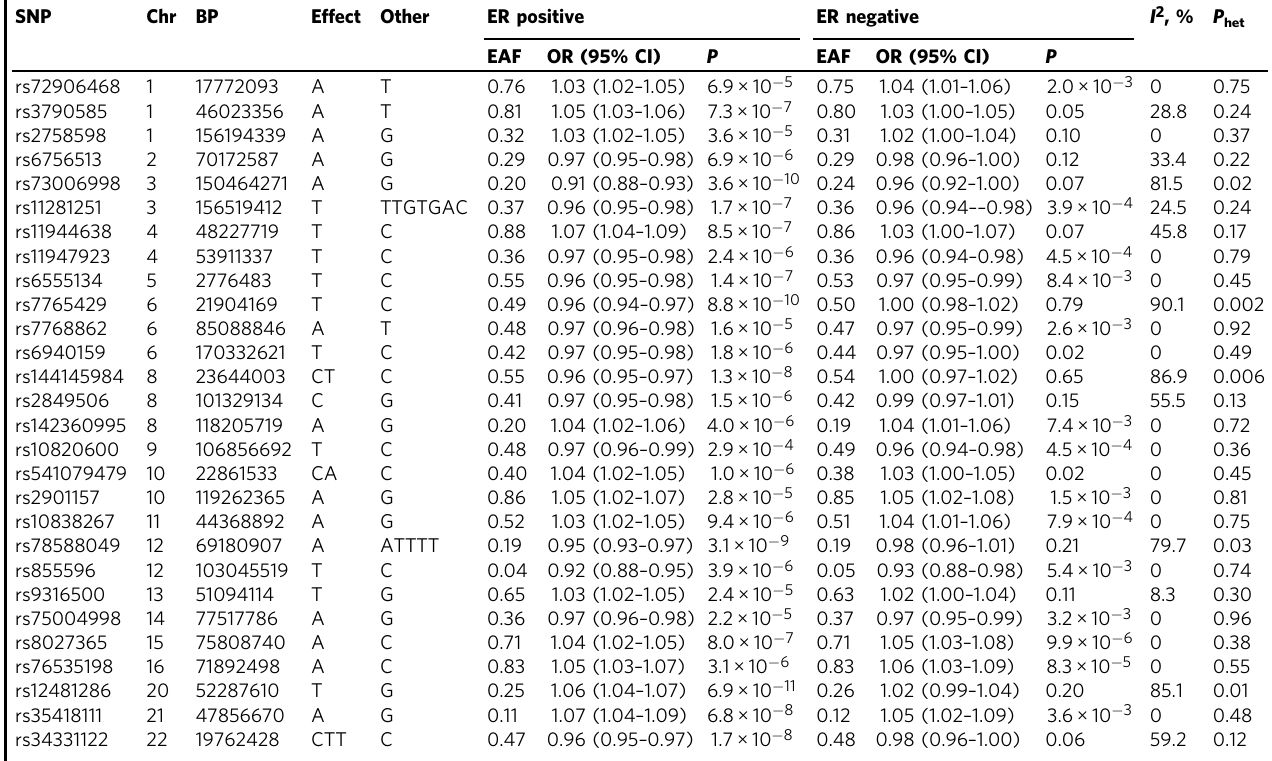
Table 2 Association analysis of 28 newly associated SNPs by estrogen receptor status.